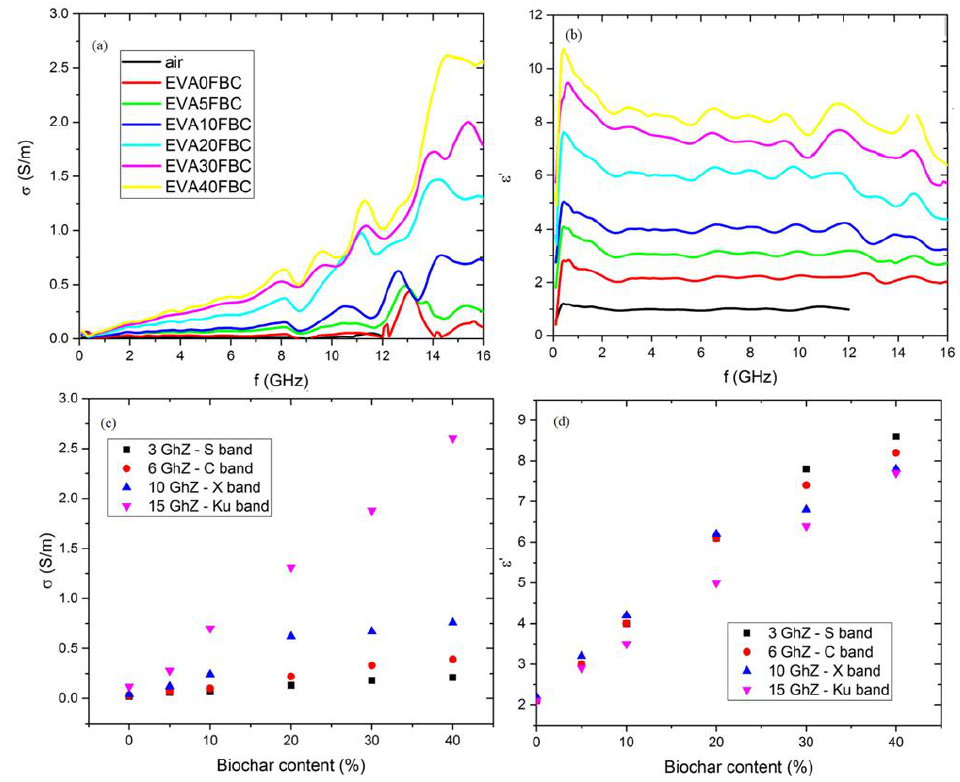
Figure 6. Conductivity ( a ) and real part of the complex permittivity ( b ) as a function of frequency; conductivity ( c ) and complex permittivity ( d ) as a function of HFB weight fraction at representative frequencies for communication microwave bands.